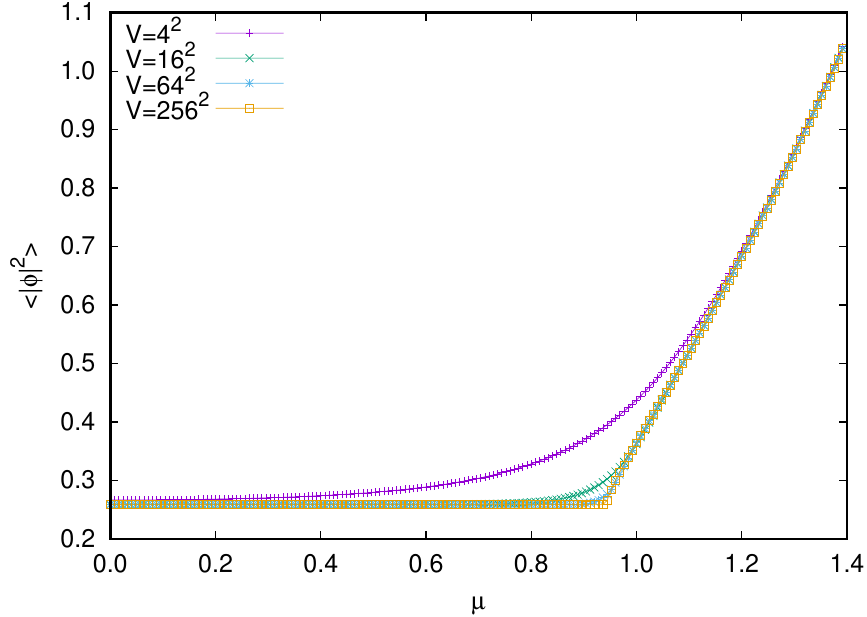
Figure 7 . hj (cid:30) j 2 i as a function of (cid:22) . The other parameters ( m , (cid:21) , K , D and V ) are the same as those of (cid:12)gure